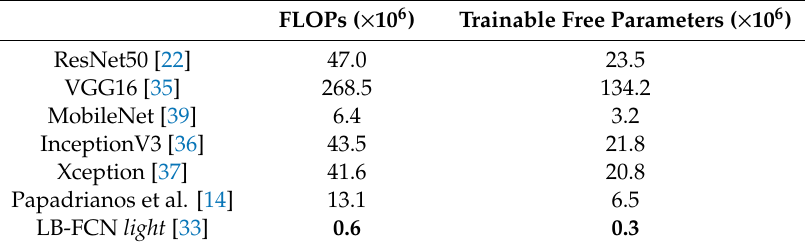
Table 6. Computational performance